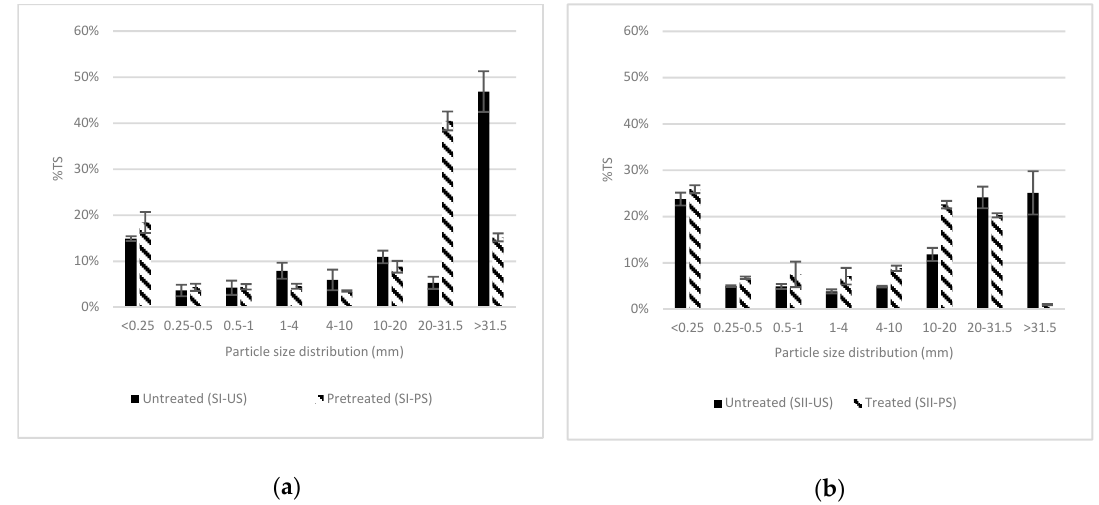
Figure 2. Particle size reduction before and after hammer milling pretreatment: ( a ) Site I; ( b ) Site II.